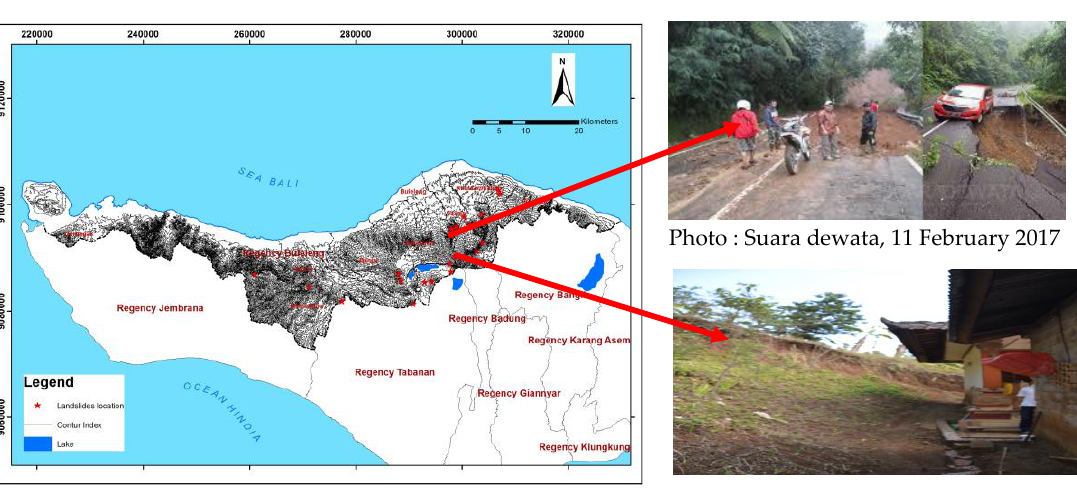
Figure 1. Landslide area in the Buleleng district.